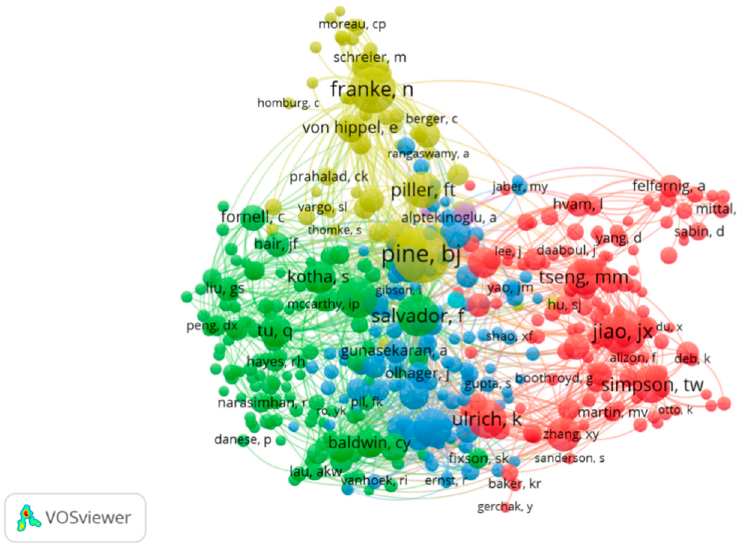
Figure 5. Co-Citation of Mass Customization researchers in 1990–2020. Source: Composed by the authors using VosViewer software .